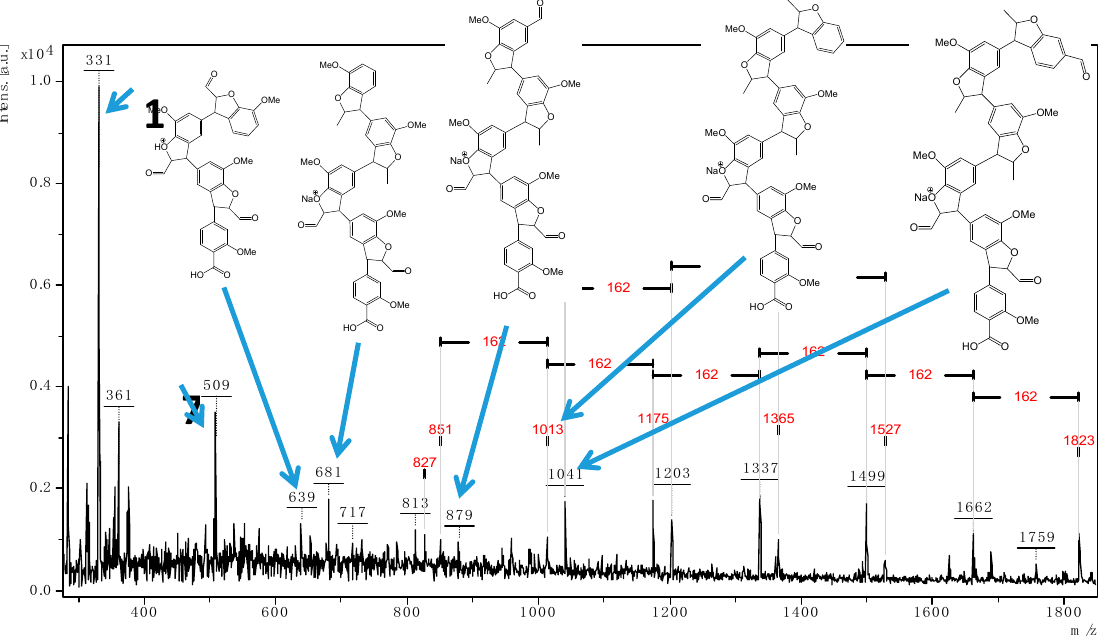
Figure 2. Positive ion MALDI TOF mass spectrum of L9 in the mass range 300–1800 Da.